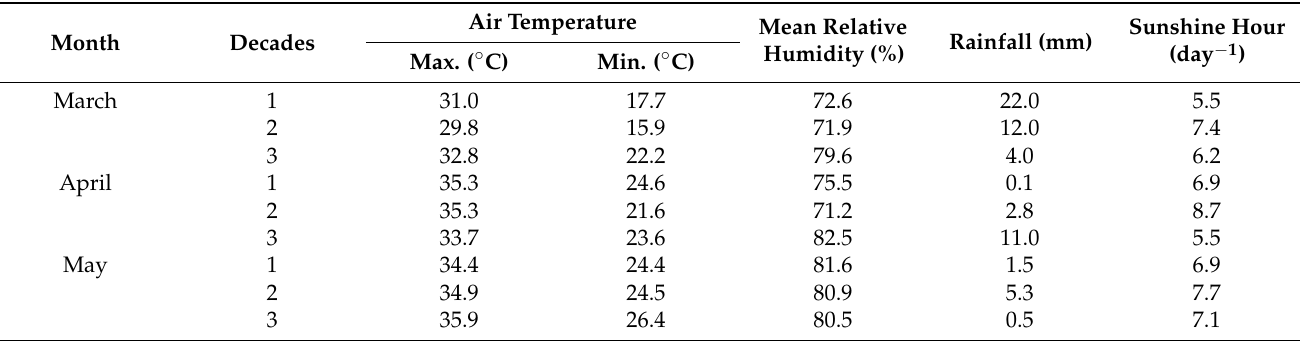
Table 4. Decades wise (10th days mean) weather information during the study